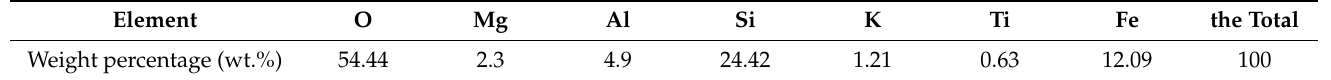
Table 1. EDS spectrograms of the Fe-loaded attapulgite particles and distribution of elements. Element the Total Weight percentage (wt.%)